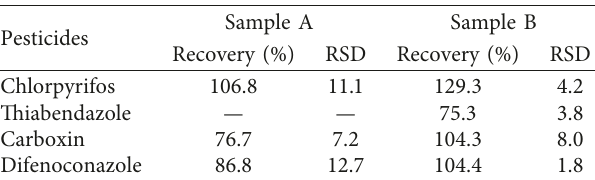
Table 4: Pesticide residue recoveries from two samples of the caj´a- manga pulp fortified with pesticides, purchased from greengrocers in Triˆangulo Mineiro, Brazil ( n �